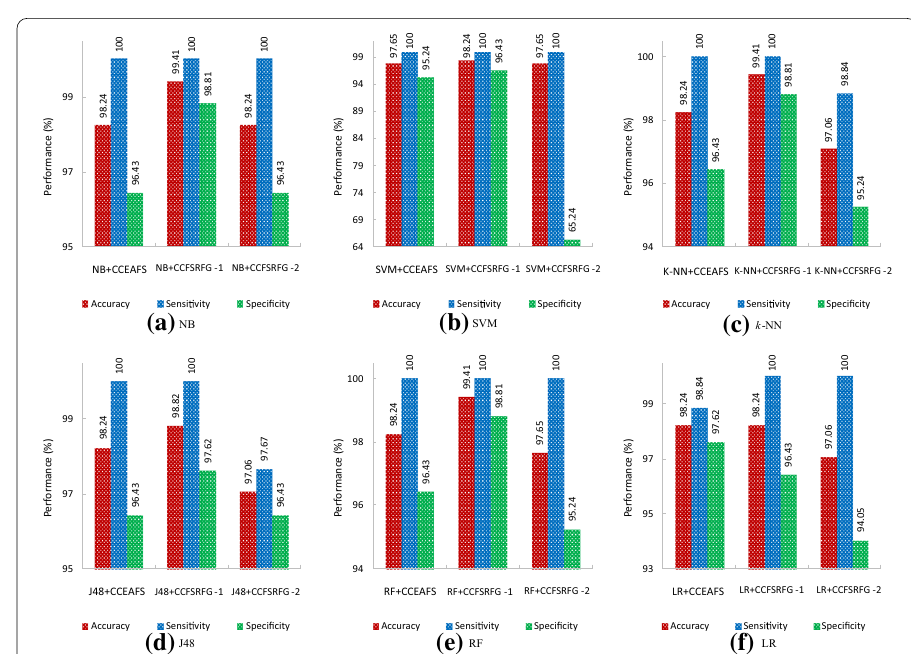
Fig. 8 Performance evaluation of classifiers on the Divorce Dataset